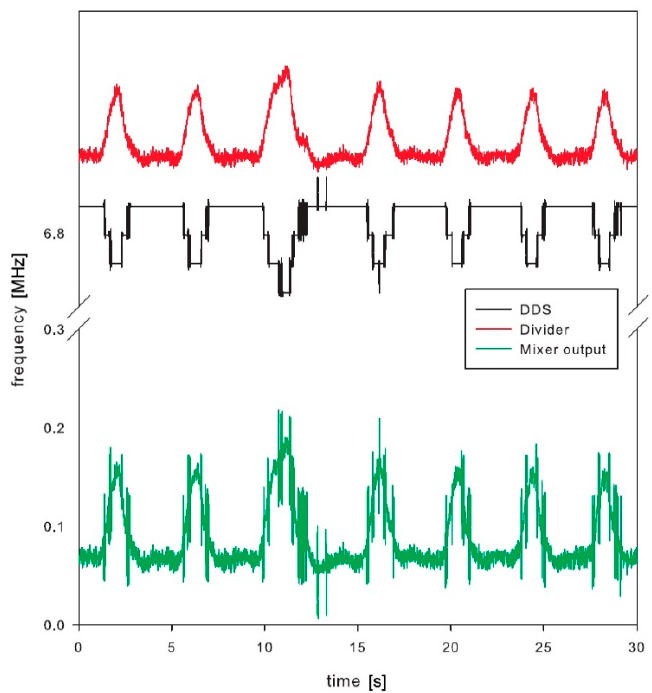
Figure 9. Final results from respiratory sensor test.